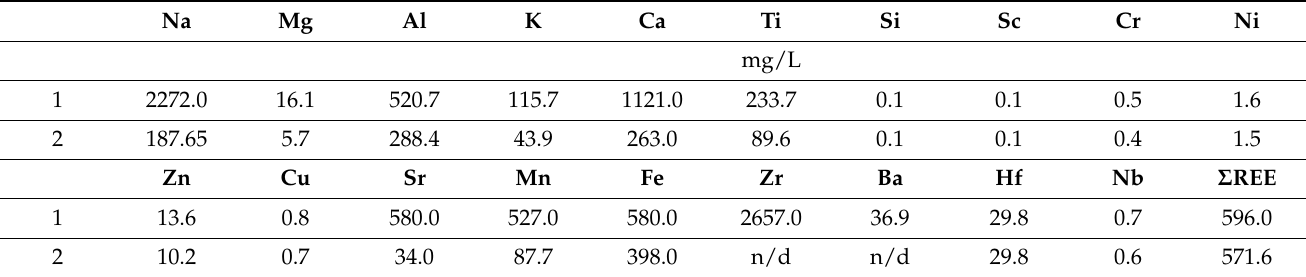
Table 4. Composition of the pregnant leach solution and refined REE solution.